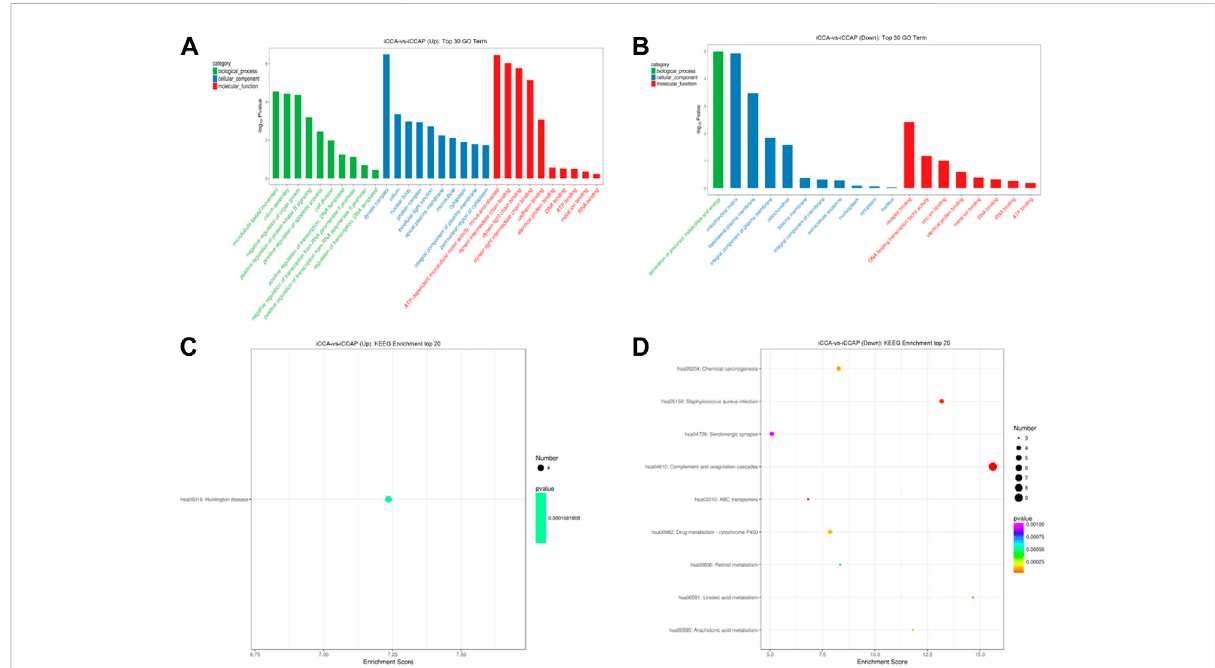
FIGURE 4 GOannotationandKEGGpathwayanalysisoftheDEcircRNAs. (A) GOannotationoftheupregulatedcircRNAswithparentaltranscripts. (B) GO annotation of thedownregulated circRNAs with parental transcripts. Only thetop 30GO termsare shown inthe fi gures. (C) KEGGpathwaysanalysis oftheupregulated circRNAs withparentaltranscripts. (D) KEGGpathwaysanalysisofthedownregulatedcircRNAswith parentaltranscripts.Onlythe top 20 enrichment KEGG pathways are shown in the fi gures.